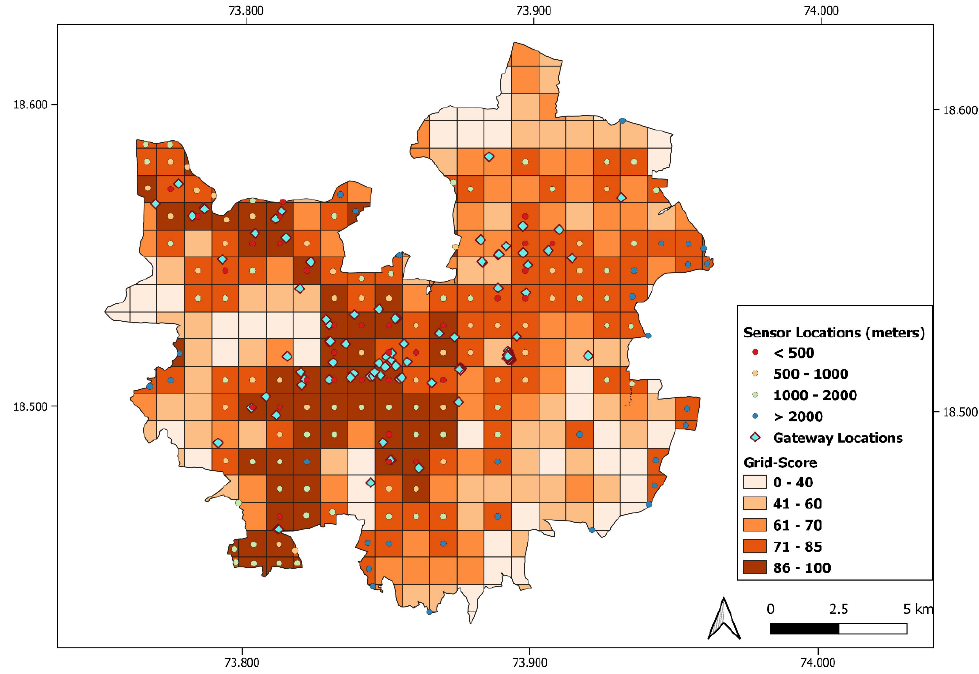
Figure 6. Color ‐ coded network scheme for sensor placement. Figure 6. Color-coded network scheme for sensor